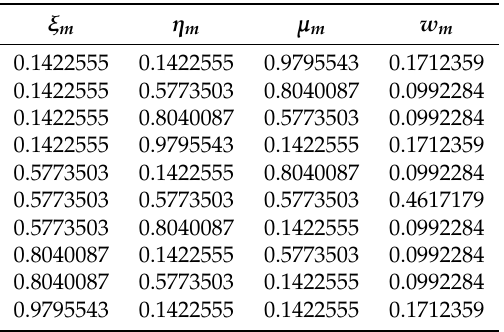
Table 1. Discrete cosines and weights used for the S 8 approximations